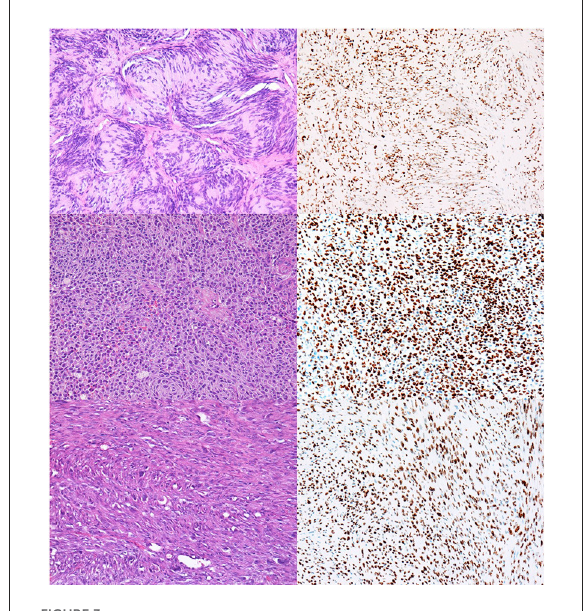
FIGURE3 NSTs with complete retention of H3K27me3 expression. (A,B) Classic schwannoma with Verocay bodies. HE, 200x (A) and H3K27me3 (B) . (C,D) Epithelioid MNST. HE, 200x (C) and H3K27me3, 200x (D) . (E,F) Conventional MNST with